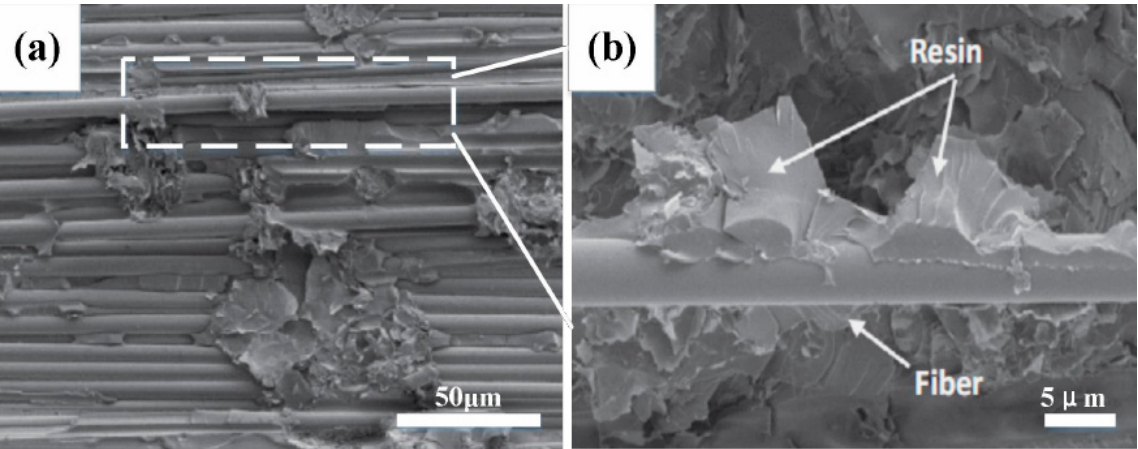
Figure 9. ( a ) Micro crack of braided fiber bundle HCS; ( b ) enlarged view of the white area in Figure 9 ( a ).